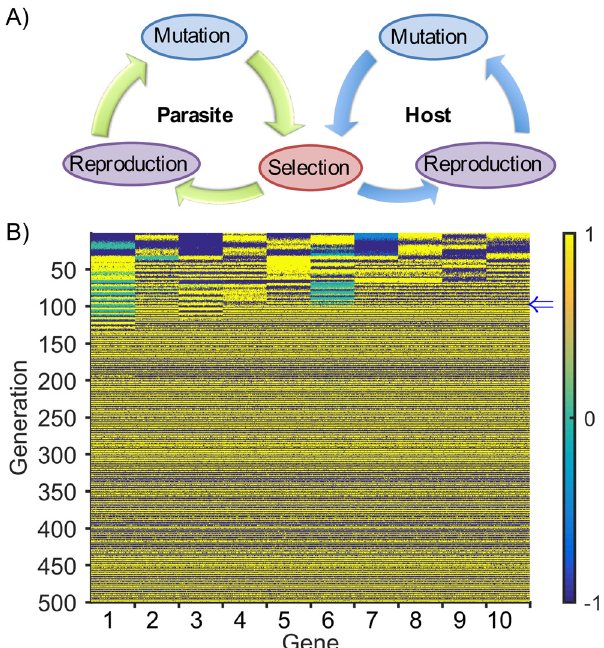
Fig 1. Host-parasite model and alternating phenotype dynamics. A) Schematic overview of the host- parasite model. B) To compare host and parasite phenotypes, here in a typical simulation, gene expressions are rescaled from [0,1] to [ − 1,+1] so that for each gene the sign of their multiplied gene expression indicates whether their expressions are similar or different. Host and parasite phenotypes are compared, here in a typical simulation, by multiplying the expression of each gene, rescaled from [0,1] to [ − 1,+1], from one host and one parasite at each generation. In the horizontal direction, the leftmost block of columns represents the comparative expression (by multiplication of rescaled expressions) level of gene 1 for 200 host-parasite pairs (the pairings themselves are random). Similar gene expression between host and parasite is shown in yellow (parasite winning) and divergent expression in blue (host